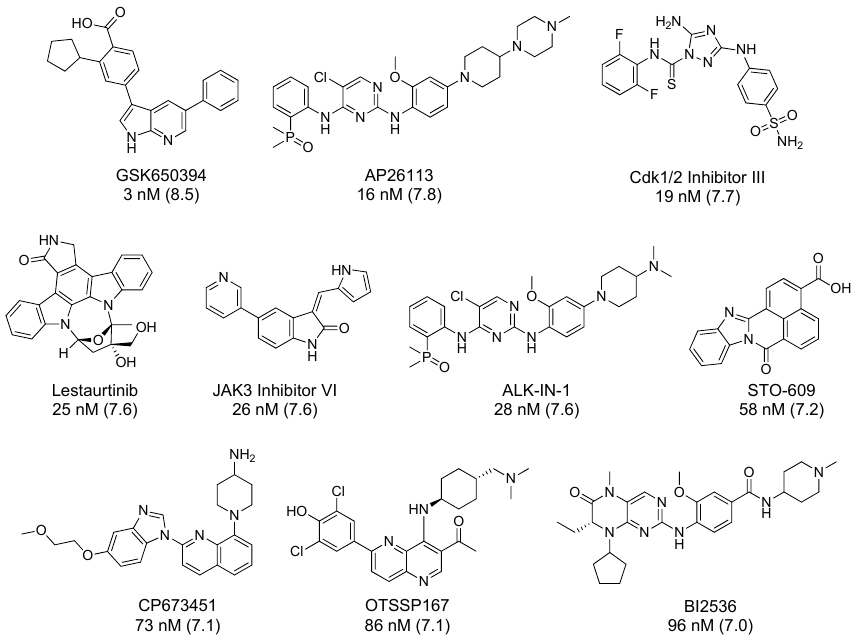
Figure 6. The 10 most potent CAMKK2 inhibitors identified in our CAMKK2 enzyme inhibition assay. The IC 50 values we generated are shown under the compounds and the corresponding pIC 50 values are shown in parentheses.